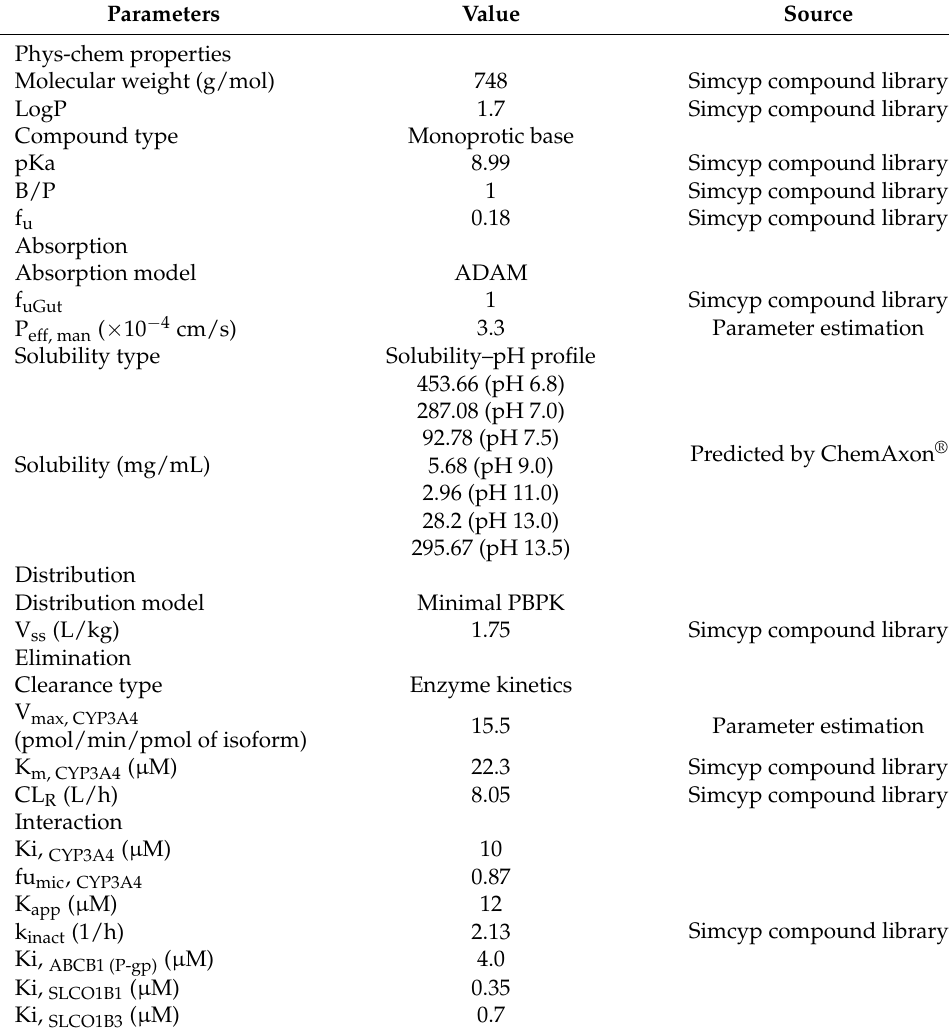
Table 3. Final input parameters for clarithromycin PBPK model.